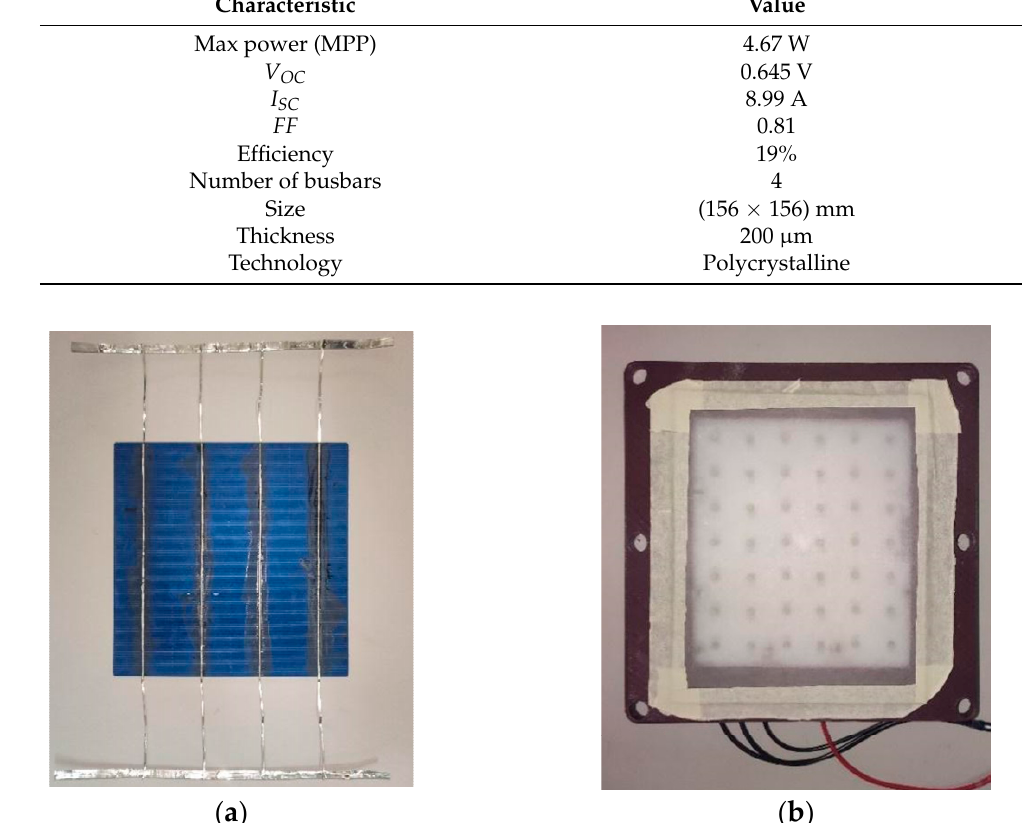
Figure 15. ( a ) Photovoltaic cell used. ( b ) LED illumination system used. Table 1. Technical characteristics of the PV cells used at nominal conditions (1000 W/m 2 of solar spectrum and 25